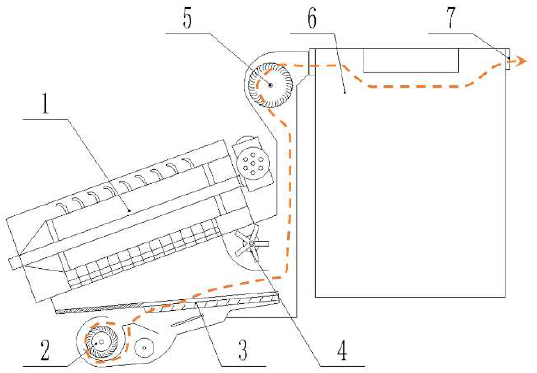
Figure 1. Schematic of dust emission flow of peanut whole-feed harvester: 1. Threshing cylinder. 2. Cleaning fan. 3. Cleaning screen. 4. Stalk crushing blade. 5. Stalk lifting fan. 6. Stalk collecting box. 7. Dust outlet. (Note: Orange dotted line indicates the direction of dust exhaust airflow).